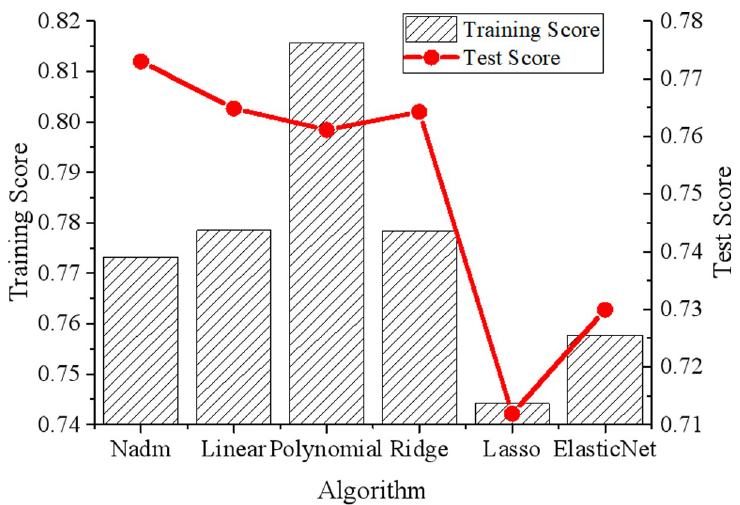
Fig 11. Comparison of salary forecast results of different